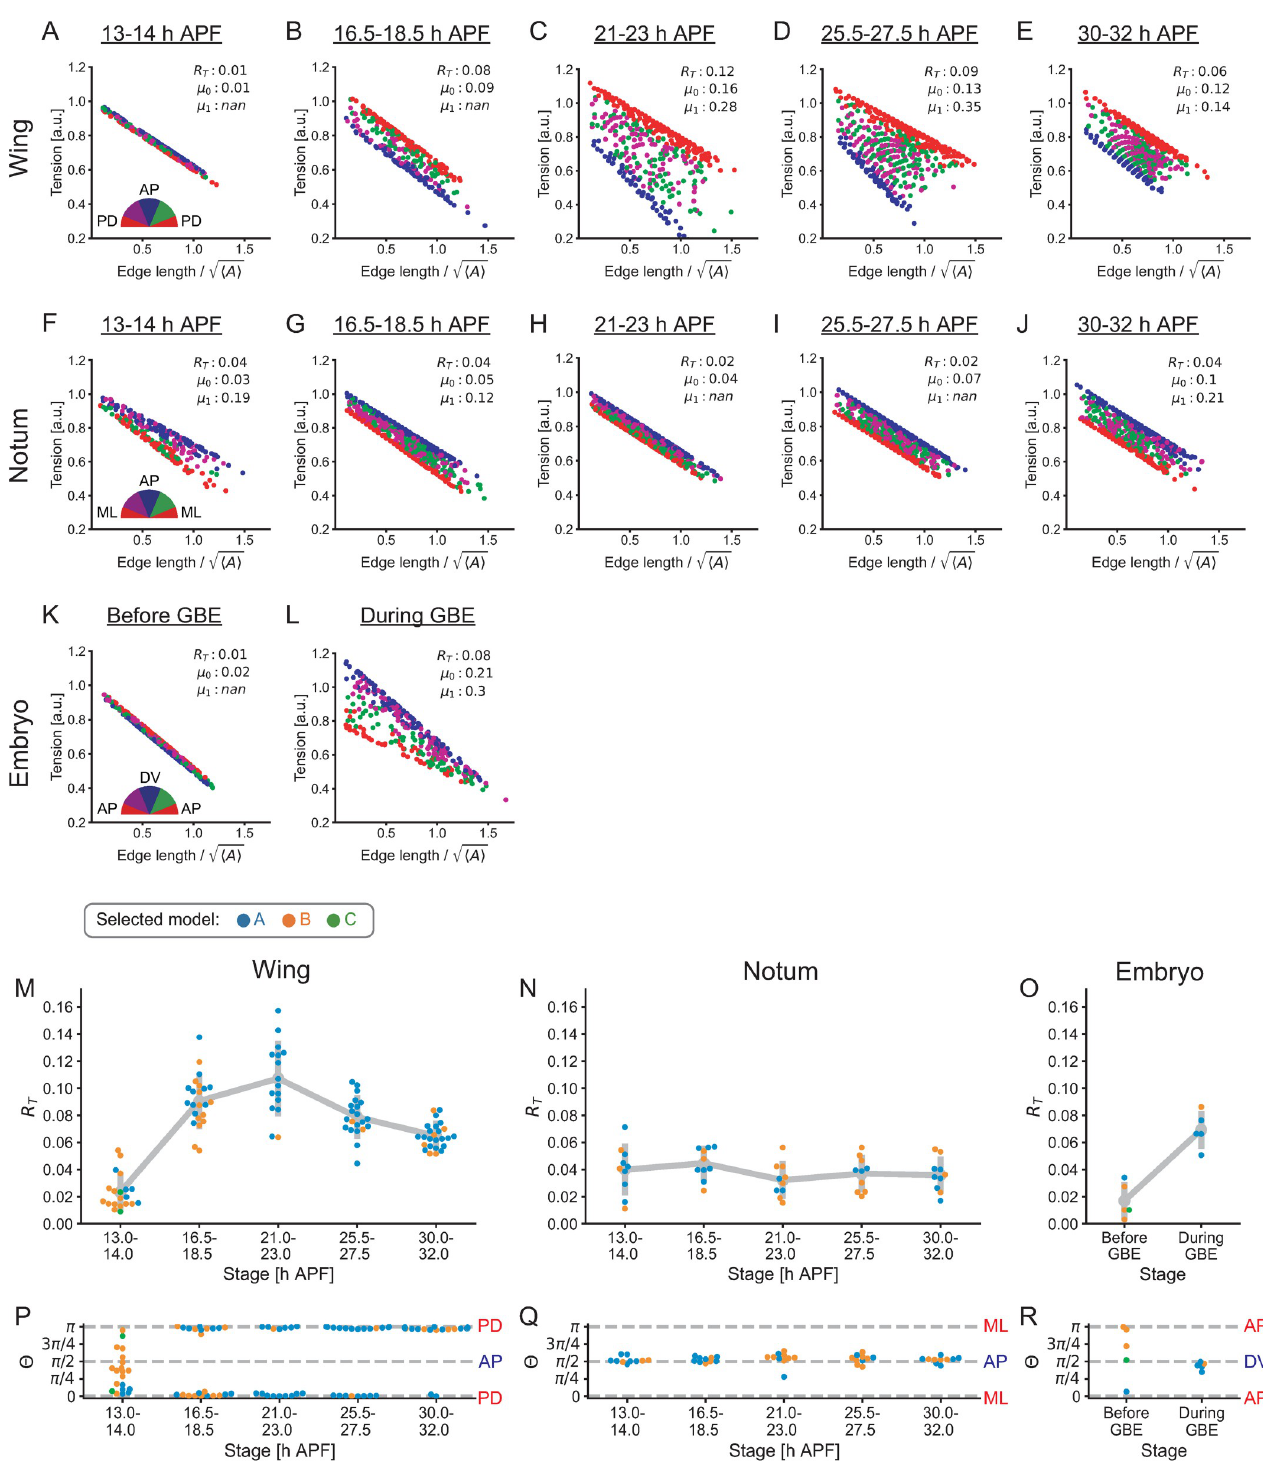
Fig 5. Developmental changes in predicted tensions in Drosophila epithelial tissues. (A–L) Junction tension predicted by estimated parameters is plotted against the junction length at the stage indicated in the pupal wing (A–E), pupal notum (F–J), and embryo (K, L). Estimated values of R T , μ 0 and μ 1 are shown in the upper right corner. A semicircle indicates the classification of junctions based on their orientation for each tissue (PD: proximal-distal, AP: anterior- posterior, ML: medio-lateral and DV: dorsoventral). (M–R) Developmental changes in the anisotropy of the predicted tension ( R T ; Materials and Methods) and its orientation ( Θ ). Each dot shows the value of R (M–O) or Θ (P–R) in each sample at the stage indicated in the pupal wing (M, P), pupal notum (N, Q), and T embryo (O, R). The gray line connects the average values of R T for each stage. Error bars indicate the s.d. Dot colors represent a model selected by AIC.